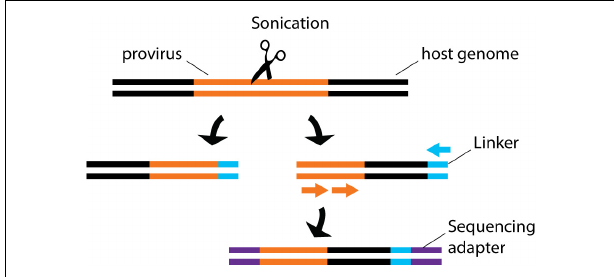
FIGURE 4 | Schematic representation of integration site sequencing. Sonication produces random DNA cleavage sites across the host genome. Linker primers are ligated to provide a template for semi-nested provirus amplification. Sequencing primers are then ligated to allow sequencing. The random cleavage ensured by the sonication produced fragments of unique sizes, thus providing single-cell